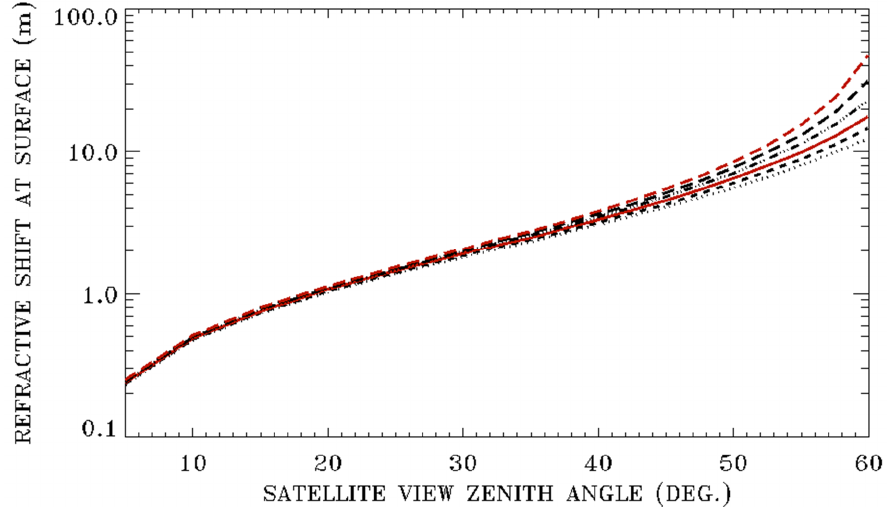
Figure 3. From the top to bottom curves—refractive surface pixel shifts versus satellite downward view zenith angles for satellite altitudes of 800, 700, 600, 500, 400, and 300 km, respectively, for green light (550 nm) and the US 1976 model atmosphere.